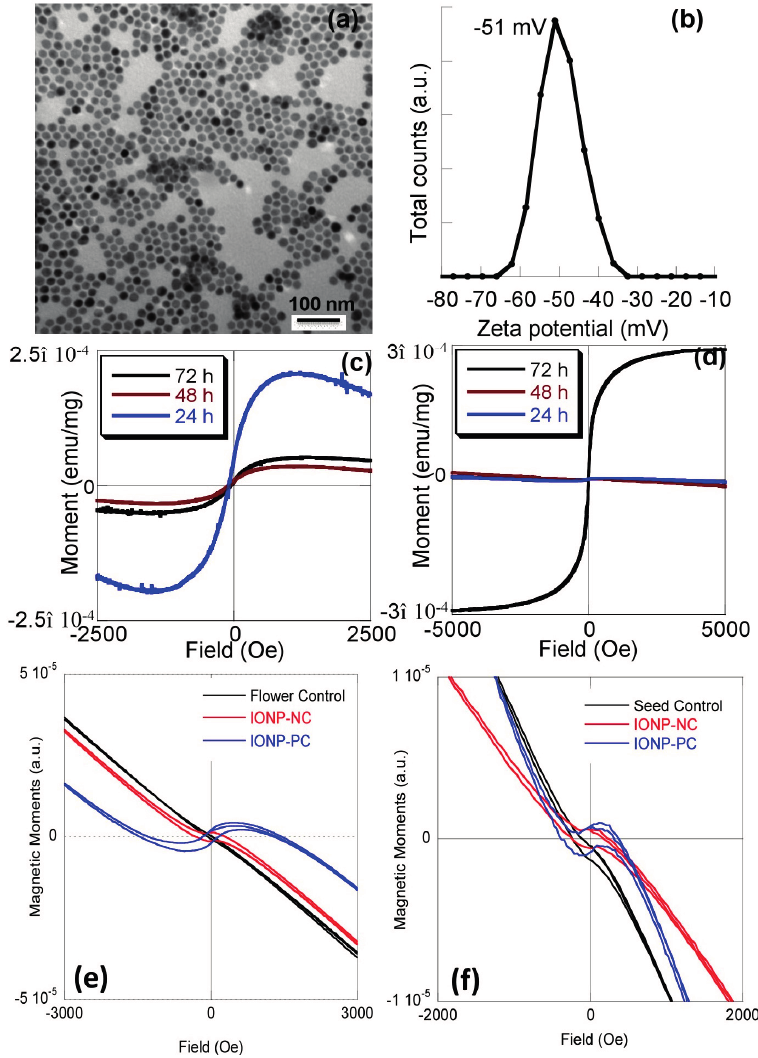
Figure 1. Transmission electron micrograph (TEM) imaging and magnetic moment measurements of iron oxide nanoparticles (IONP) transport in A. thaliana tissues. ( a ) TEM image of the iron oxide NPs used in this experiment, showing spherical shape; ( b ) Zeta potential plot of the IONP-NC solution; ( c ) Magnetic measurements of the root tissues at 24, 48 and 72 h after watering with 30 mL of a 3 mg/L IONP-NC; ( d ) magnetic measurement of the leaf tissues at 24, 48 and 72 h after watering with 30 mL of a 3 mg/L IONP-NC; ( e , f ) magnetic moment measurements of IONP-PC and IONP-NC in flowers ( e ) and seeds ( f ). 2.2. Effect of Iron Oxide Nanoparticles (IONPs) on Seed Germination, Seedling and Root